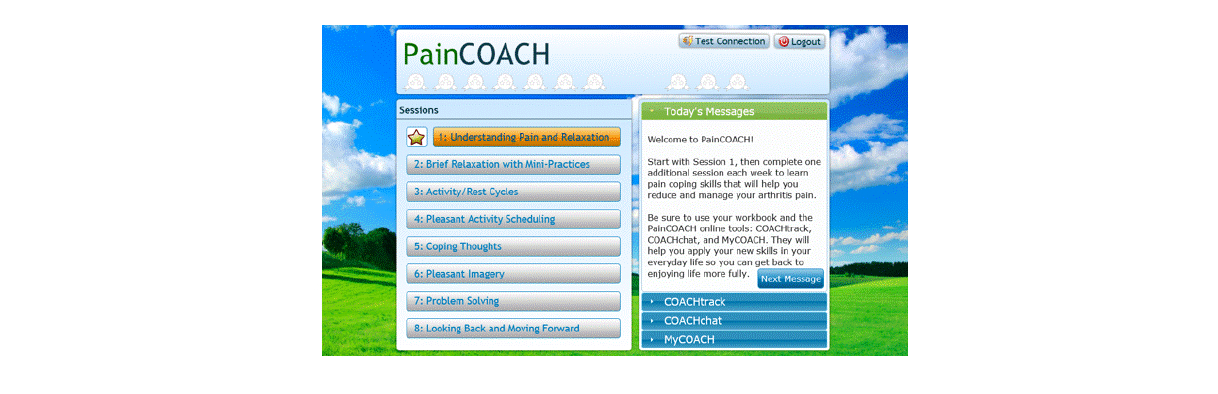
Figure 1. PainCOACH Home